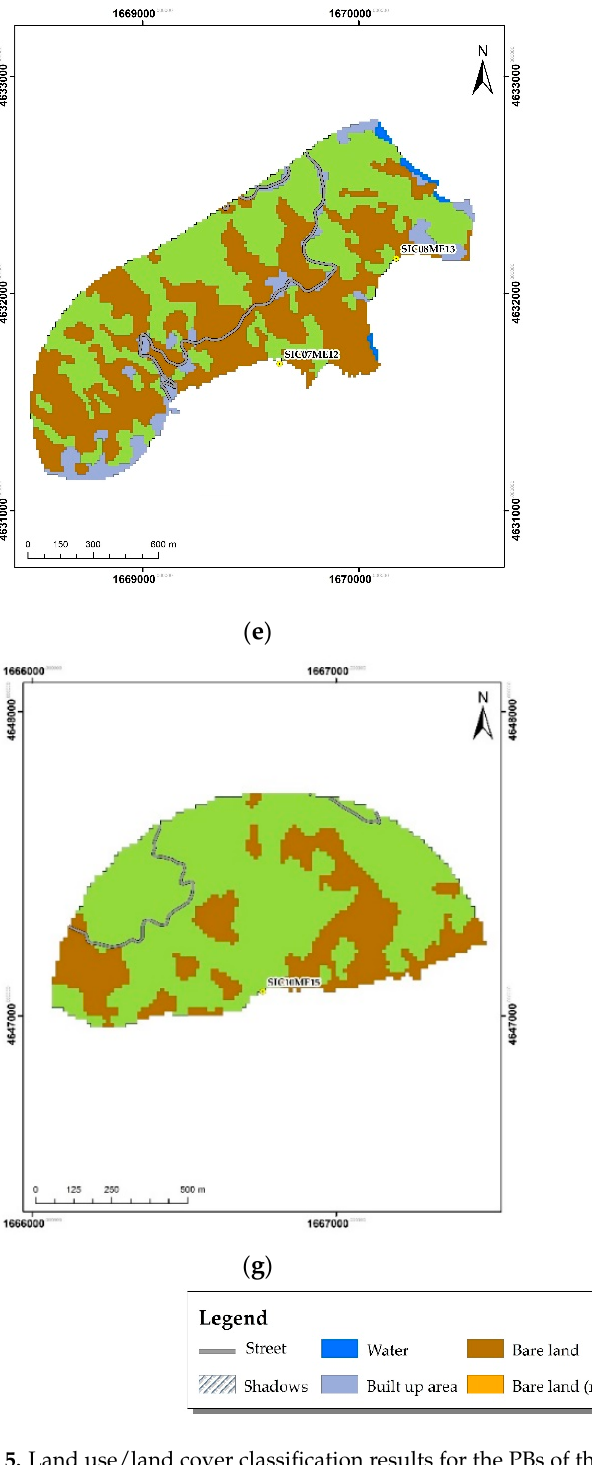
Figure 5. Land use/land cover classification results for the PBs of the Aeolian Archipelago, clockwise from top left: Filicudi—Le Punte (SIC17ME24) ( a ); Salina—Pollara (SIC14ME19) ( b ); Salina—Punta Scario (SIC13ME18) ( c ); Zimmaro (SIC15ME20), West Preistorico (SIC16ME21), Central Preistorico (SIC16ME22), and East Preistorico (SIC16ME23) ( d ); Volcano Island—Punta dell’Asino (SIC07ME12) and Volcano Island—Punta Bandiera (SIC08ME13) ( e ); Lipari-La Forbice (SIC09ME14) ( f ); Lipari—Pignataro di Fuori (SIC10ME15) ( g ); Lipari—Sabbie Bianche (SIC11ME16) and Lipari—Lido Blu (SIC12ME17) ( h ).